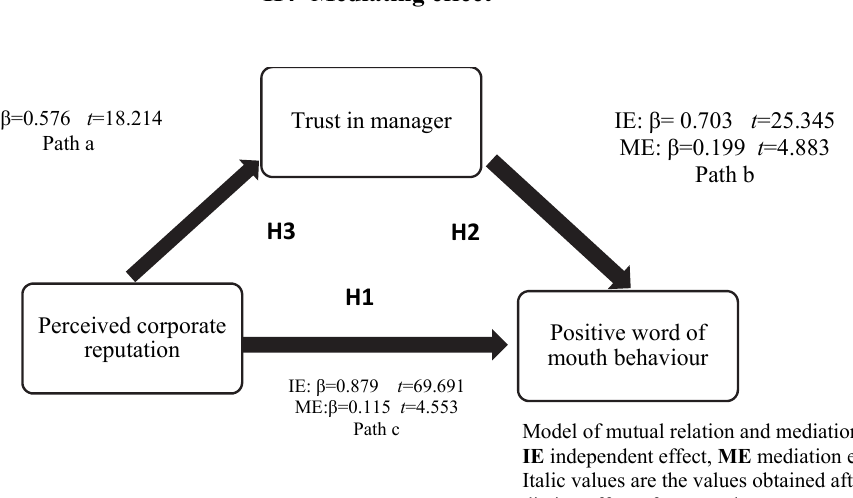
Fig. 1. Estimated PCR-TM-PWOM